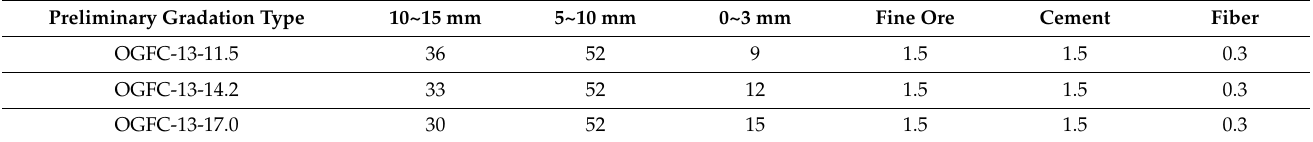
Table 6. Mixing ratios for each grade of the preliminary grading (unit: %).